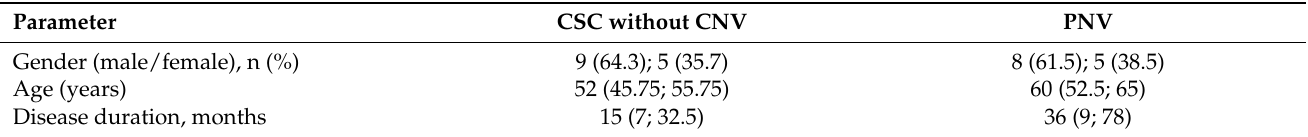
Table 4. Comparison of demographic parameters of patients with CSC without CNV and with CNV (PNV). Parameter